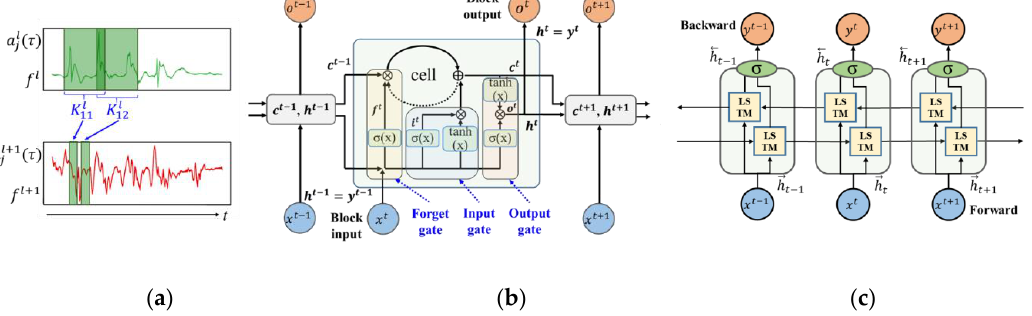
Figure 1. ( a ) Representation of one-dimensional convolutional neural network; ( b ) Long Short-Term Memory; ( c ) Bidirectional Memory; ( c ) Bidirectional LSTM.